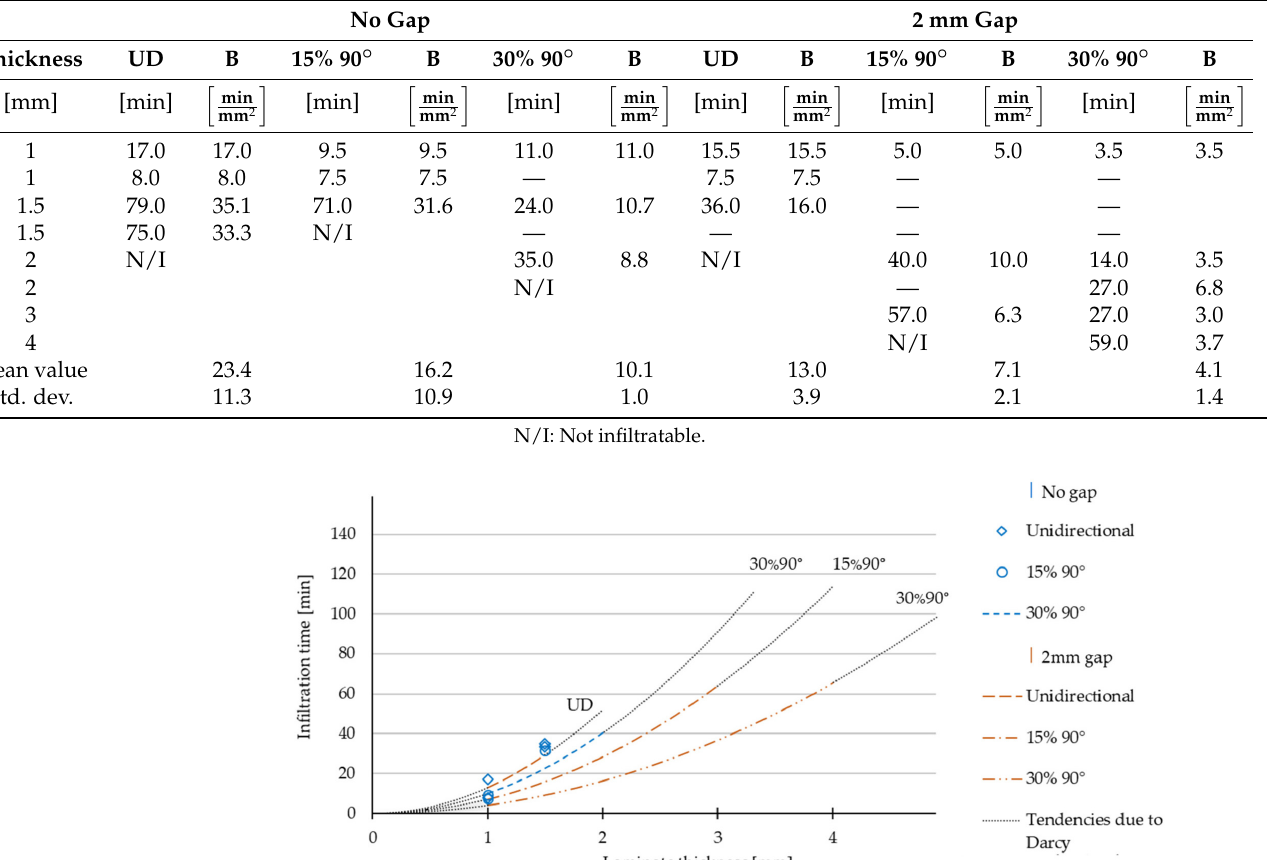
Table 7. Results of the measured infiltration times and calculated material factor B.